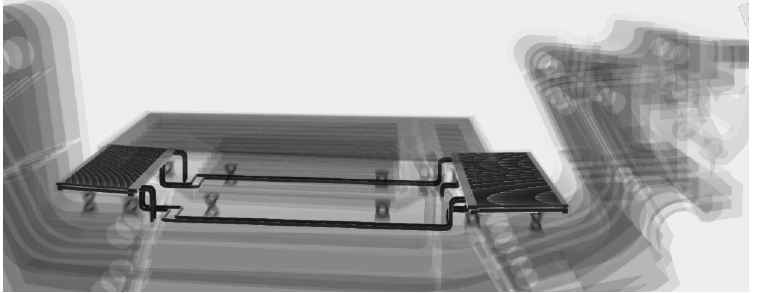
Figure 2. Representation of the EU-DEMO Divertor cassette CAD model. Liner and reflector plates cooling channels are